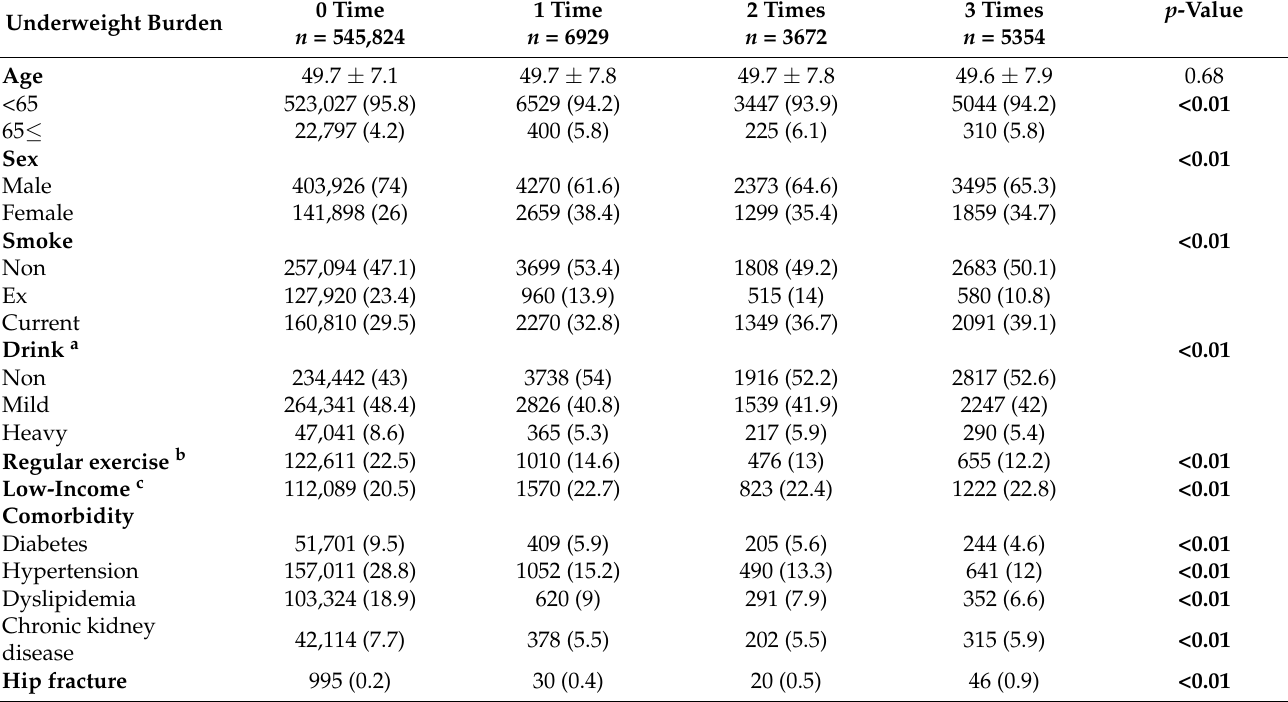
Table 1. Baseline characteristics of participants according to the burden of underweight.